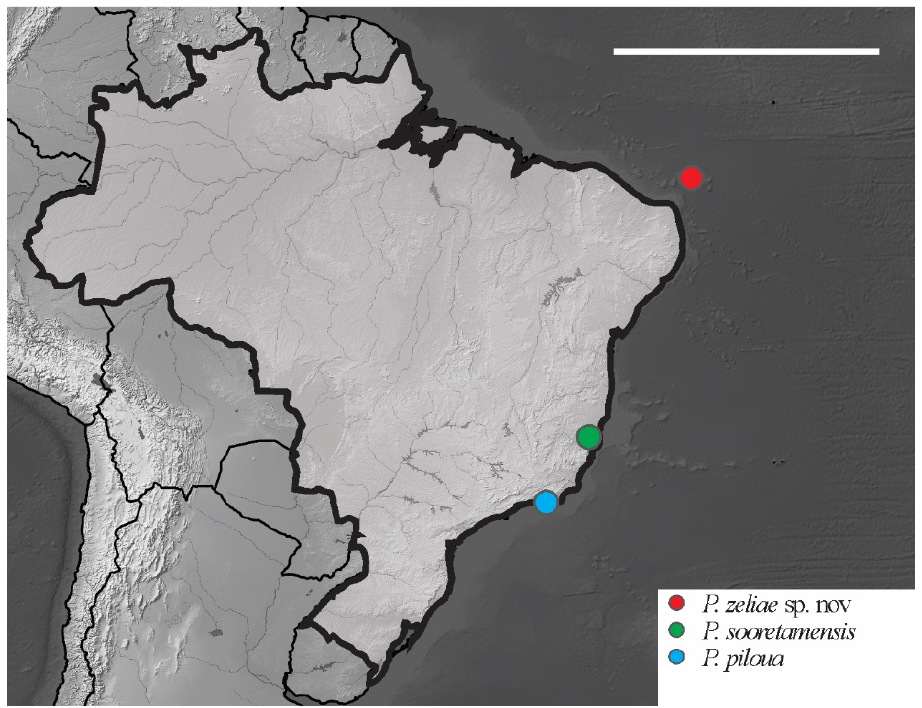
Figure 18. Distribution map for Paraxenylla Murphy, 1965 species recorded in Brazil. Scale bar: 3000 km. Description. Habitus typical of the genus. Color in ethanol white. Tegumental gran- ulation fine and regular. Body length: 490 µ m ( n = 5); holotype measurements as in Table